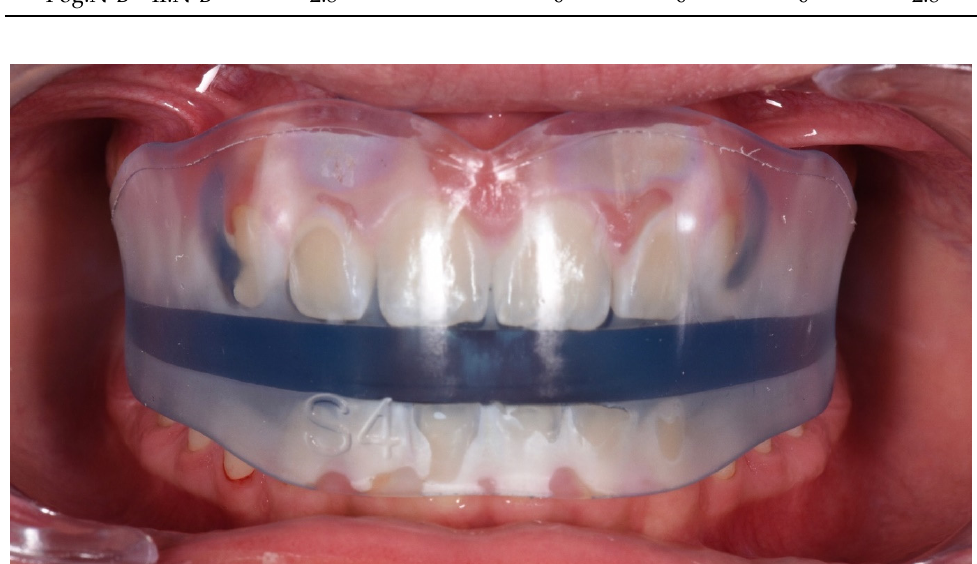
Figure 7. Intraoral photograph with the AMCOP Integral